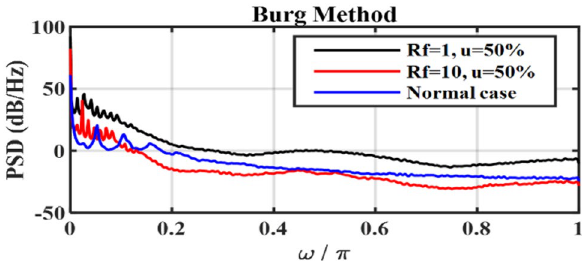
Fig. 4 The current’s PSD estimation based Burg at different operating